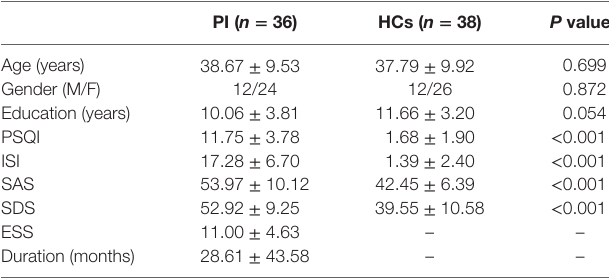
TaBle 1 | Demographic, neuropsychological, and clinical characteristics of the